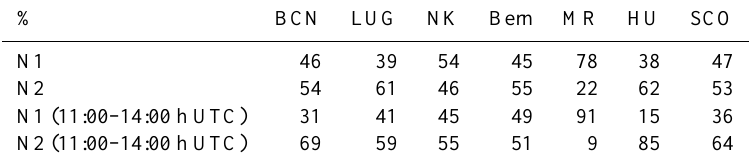
Table 6. Total average percentages of N1 and N2 and average percentages at midday (11:00–14:00 h UTC) on an hourly